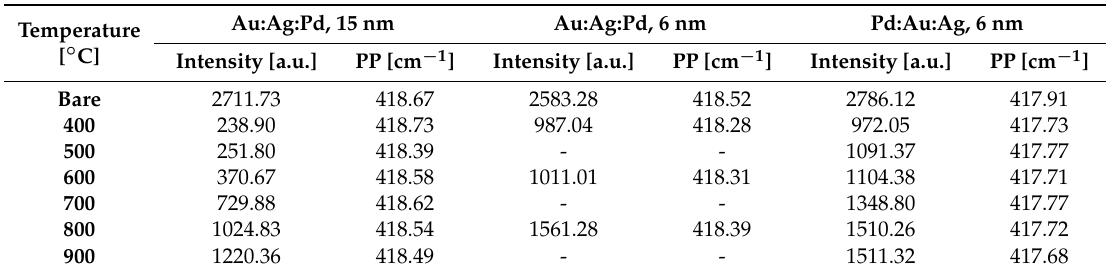
Table A3. Summary of Raman peak intensity and peak position (PP) of the samples with distinct temperature, composition, and thickness.